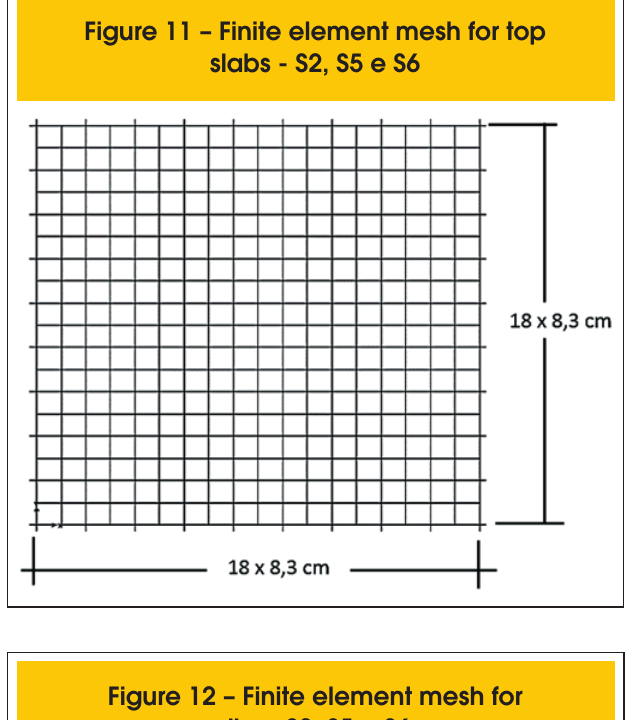
Figure 12 – Finite element mesh